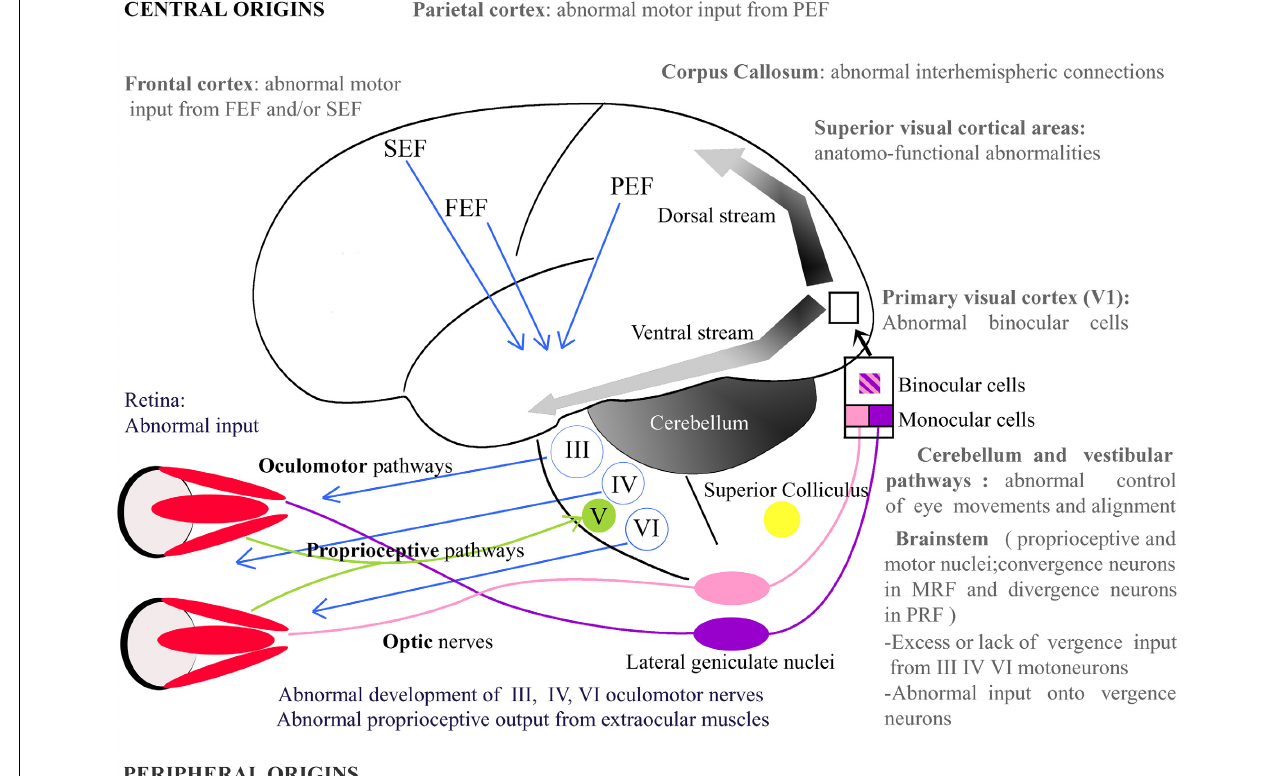
FIGURE 2 | Potential origins of strabismus. Strabismus may have sensory and/or motor origins as well as peripheral and/or central origins. In periphery, one may notice, for example, abnormal vision or abnormal development of the extraocular muscles. In the latter, the extraocular muscles’ proprioceptive afferents reaching the Gasser ganglion normally through the ophthalmic branch of the Vth (trigeminal) cranial nerve and/or their oculomotor nerves, i.e., the IIIrd, IVth, and the VIth cranial nerves, may be also altered. Centrally, strabismus may, for example, result from an